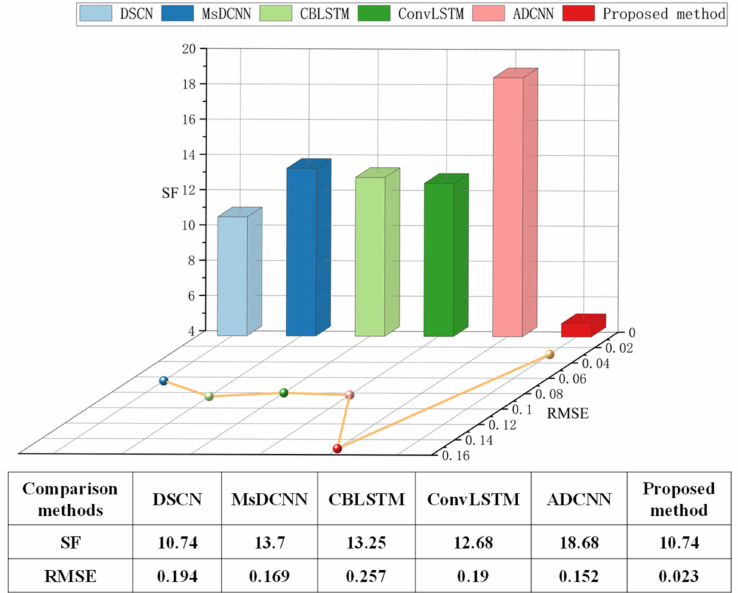
Figure 19. SF and RMSE comparison results for the PHM 2012 beaing1_3.